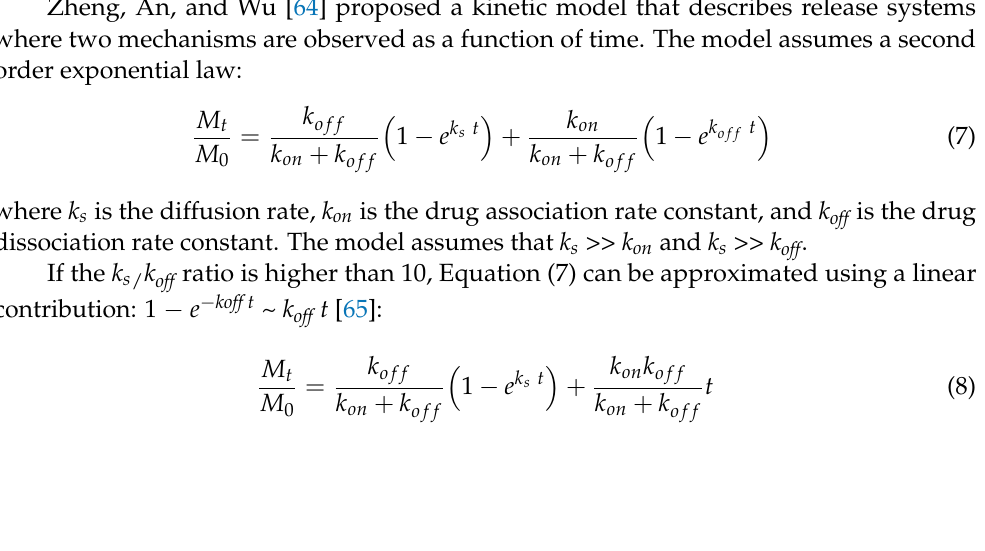
Figure 7. In vitro AmB release profile for acylated nanoparticles: CGAc AmB ( ○ ), CGProp AmB ( □ ), CGBut AmB ( ◊ ).